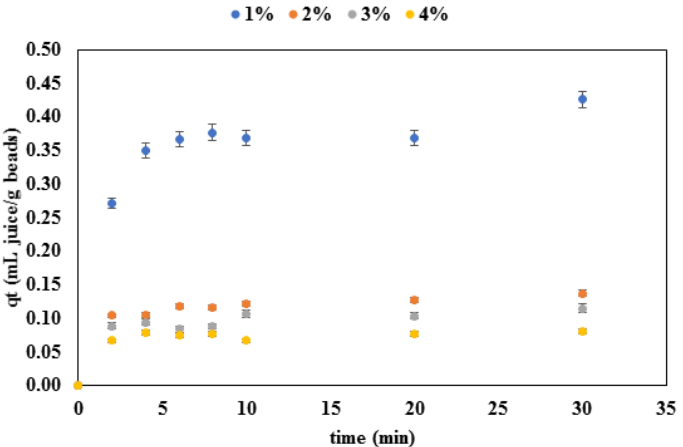
Figure 5. Concentration change dynamics during the adsorption process of the red beetroot dye on alginate microbeads.